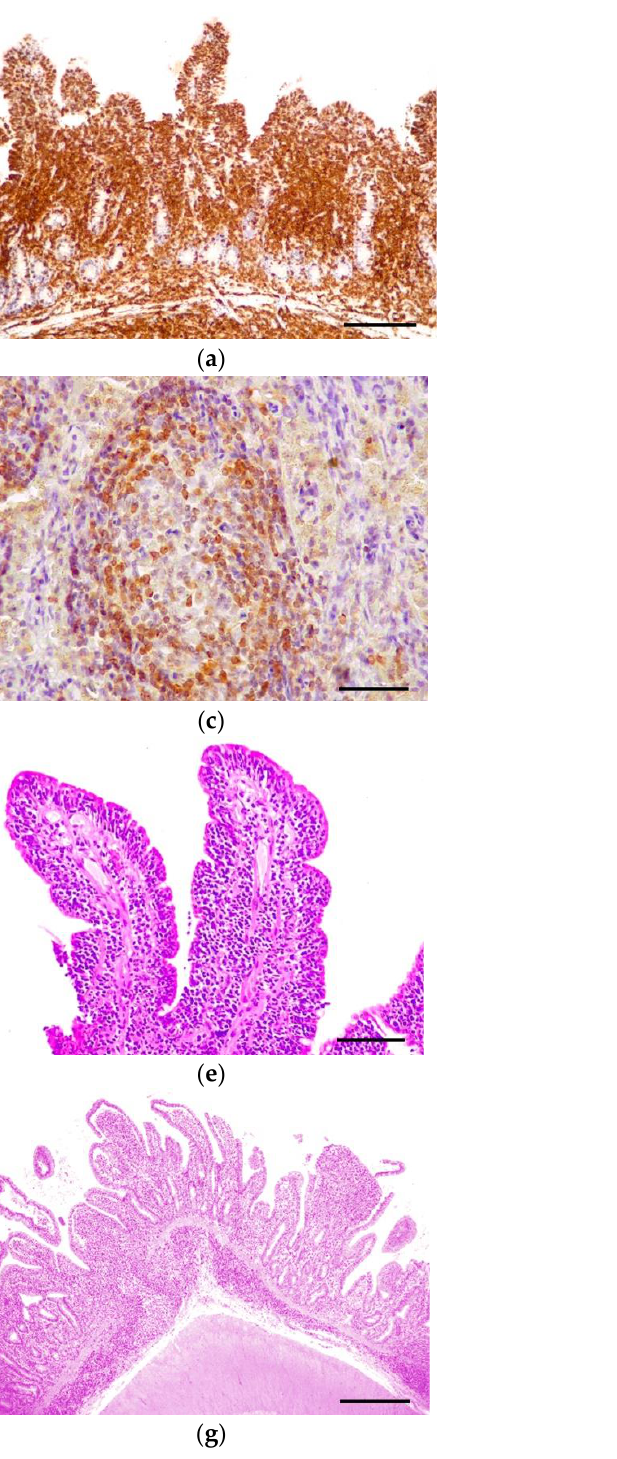
Figure 1. Feline epitheliotropic duodenal T-cell lymphoma, case 21, endoscopic biopsy: ( a ) The lamina propria is expanded by a monomorphic infiltration of T-lymphocytes. Exceptionally, the muscularis mucosae is shown, demonstrating transmural infiltration of neoplastic cells. Rabbit polyclonal anti-CD3 antibody. Scale bar: 1000 µm. ( b ) The neoplastic infiltration shows a moderate proliferation index. Proliferation is high in the stem cells of the crypts. Rabbit monoclonal anti-Ki-67. Scale bar: 1000 µm. ( c ) Bcl-2 positive control (feline mesenteric lymph node). Mantle cells of the lymphoid follicle immunoexpressed Bcl-2. Scale bar: 200 µm. ( d ) Case 2, endoscopic biopsy: Patchy pattern with formation of nests. Neoplastic lymphocytes, arranged in nests in the epithelium, showed a mild (grade 1) expression of Bcl-2 (arrows). Mouse monoclonal anti-Bcl-2 oncoprotein. Scale bar: